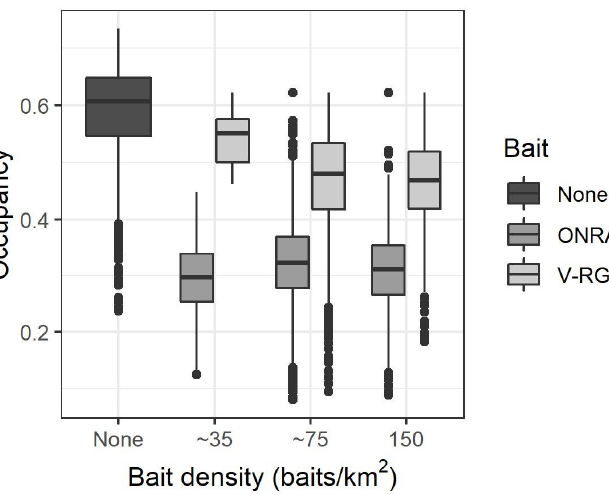
Figure 3. Boxplots of the probability of RABV occupancy estimates by bait density and bait type.